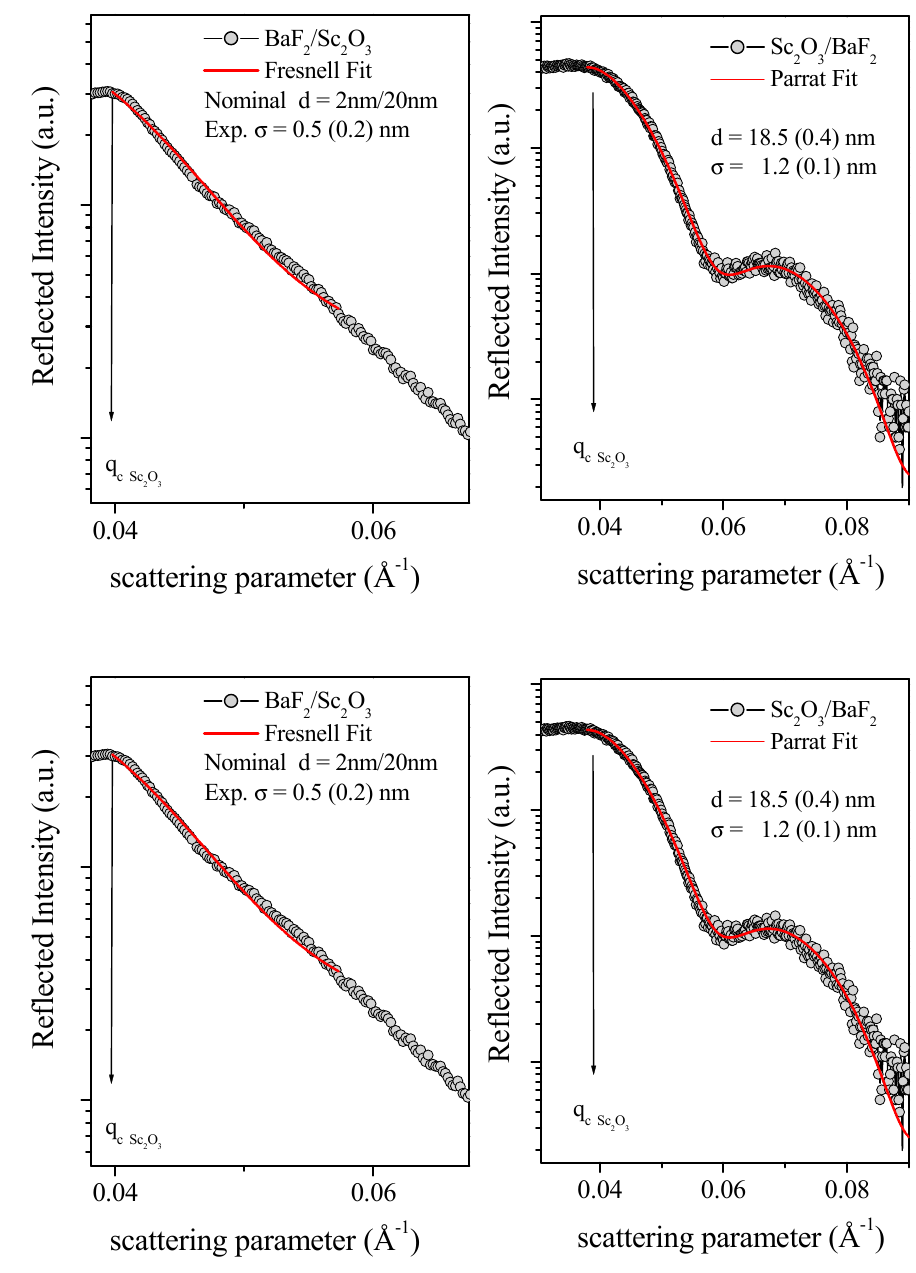
Figure 10. EDXR patterns (black dots) and fittings (red line) of the samples BaF 2 /Sc 2 O 3 (left side) and Sc 2 O 3 /BaF 2 (right side). Black arrows indicate the critical scattering value for each sample.